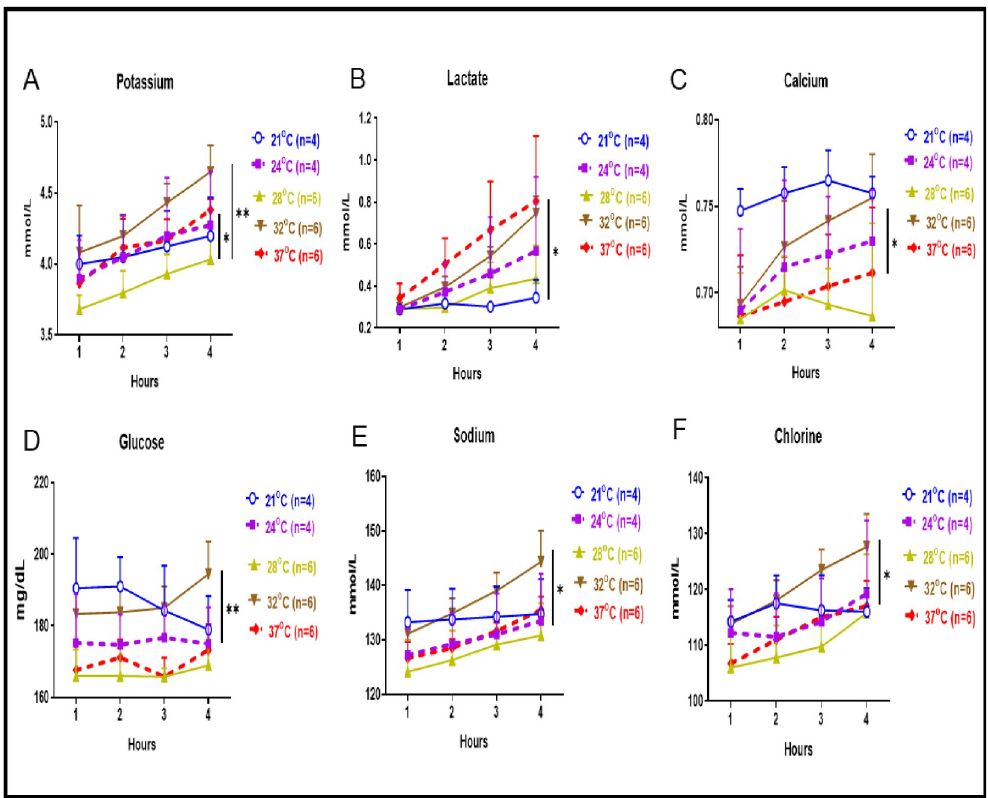
Fig 2. Clinical biochemistry parameters. (A) Concentration of potassium at 28˚C was significantly lower than 37˚C and 32˚C ( p < 0 . 05 and p < 0 . 01 respectively ), but potassium ion concentration obtained at 24˚C and 21˚C was similar to that of 37˚C. (B) Lactate levels at 21˚C and 28˚C were significantly lower than that of 37˚C ( p < 0 . 05 ).Lactate levels at 32˚C and 24˚C were similar to that of 37˚C. (C) Calcium ion perfusate concentrations was at their lowest level at 28˚C, higher at 32˚C and 24˚C and were significantly higher at 21˚C compared to the 37˚C condition ( p < 0 . 05 ). (D) Perfusate glucose concentration was significantly higher at 32˚C compared to the 37˚C condition ( p < 0 . 01 ).(E) Sodium ion concentration was at their lowest level at 28˚C and significantly higher at 32˚C compared to the normothermic 37˚C ( p < 0 . 05 ).(F) Chlorine ion concentrations was at their lowest level at 28˚C and significantly higher at 32˚C compared to the normothermic 37˚C ( p < 0 . 05